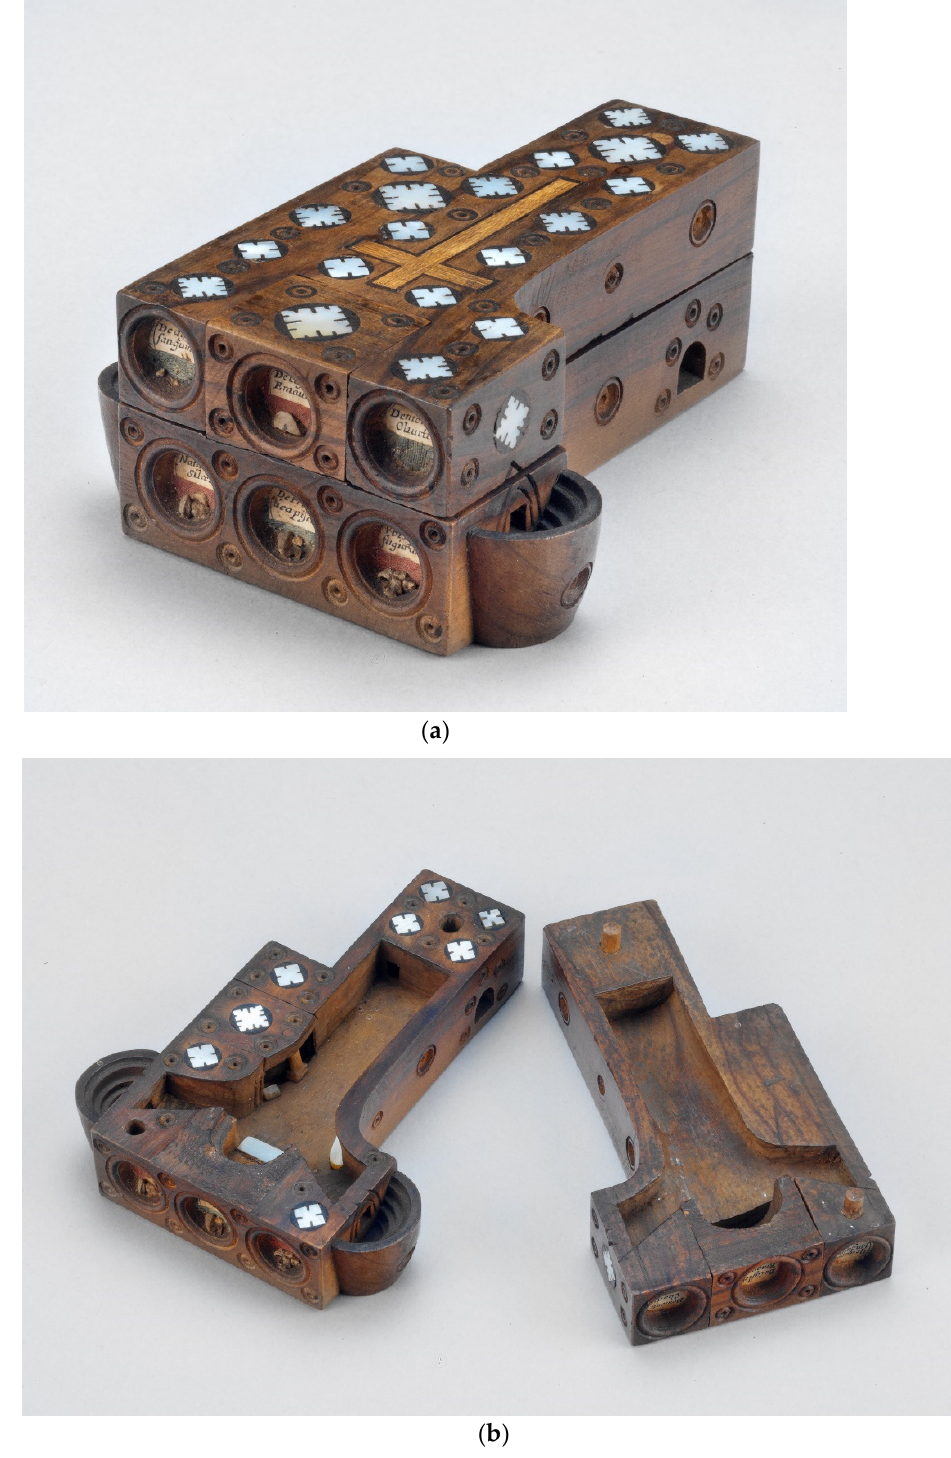
Figure 3. ( a , b ) A small wooden copy of the Holy Sepulchre in Jerusalem (inv.no. EFa6); Seventeenth Century. Photo: The Danish National Museum in Copenhagen.